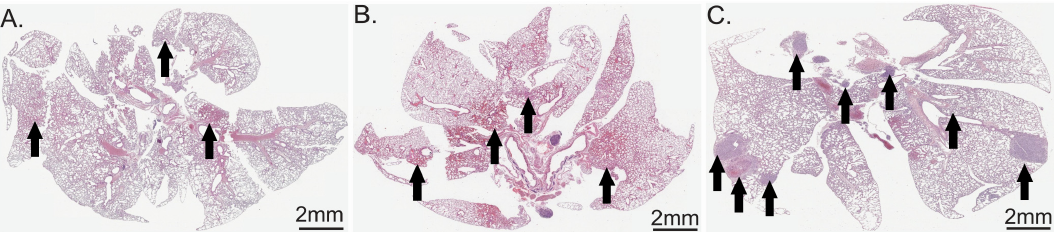
Figure 9. Hematoxylin and eosin staining of lungs. Arrows indicate metastases. ( A ) G1-21% oxygen; ( B ) G2-40% oxygen; C. G3-80% oxygen.